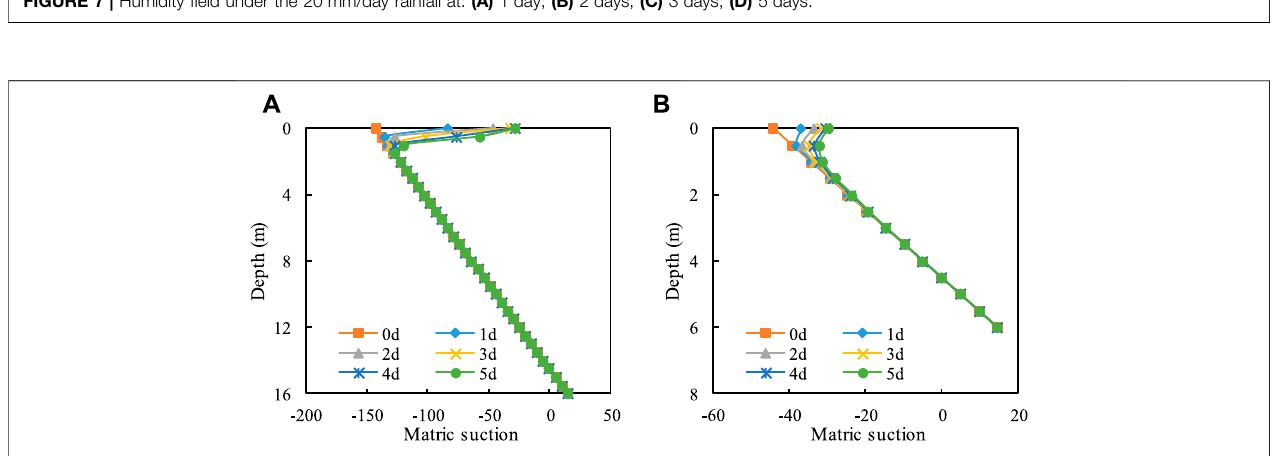
FIGURE 8 | Matric suction along the slope depth at: (A) the top and (B) the foot of the slope.